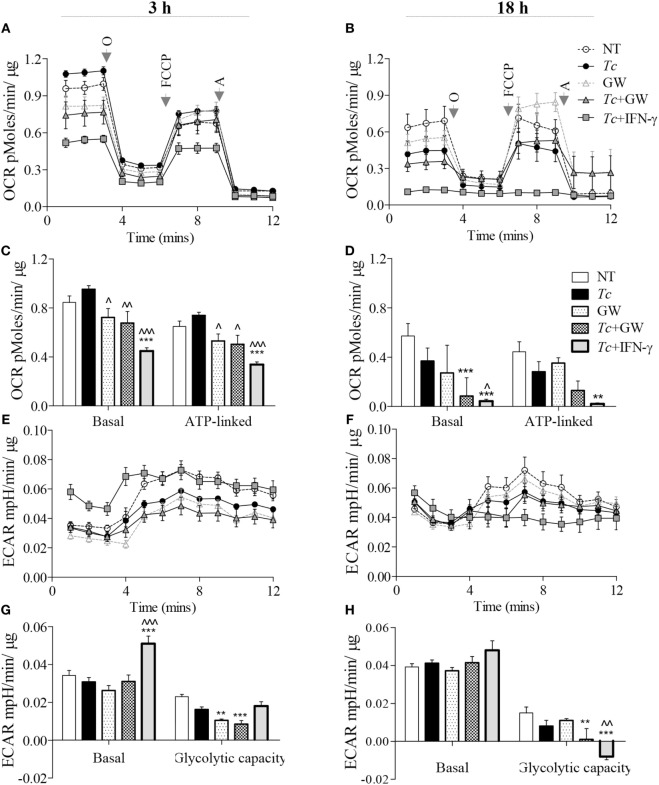
Metabolic function of macrophages infected with Trypanosoma cruzi (Tc) (±PPAR-α inhibitor). RAW 264.7 macrophages were incubated with Tc at the same time in presence or absence of IFN-γ and GW6471 (PPAR-α inhibitor) for 3 or 18 h. The oxygen consumption rate (OCR) and extracellular acidification rate (ECAR) were monitored by Seahorse Extracellular Flux Analyzer. Shown are the original recordings of OCR (A,B) and ECAR (E,F) with sequential addition of oligomycin (O), FCCP, and antimycin (A). Bar graphs show the quantification of mitochondrial stress parameters (C,D) and glycolytic capacity (G,H). All data are shown as the mean ± SEM of four replicates. Statistical significance are marked as ANOVABF **p < 0.01 and ***p < 0.001 (infected and/or treated vs. no-treatment controls) or ^p < 0.05, ^^p < 0.01, ^^^p < 0.001 (Tc infected/treated vs. Tc infected).